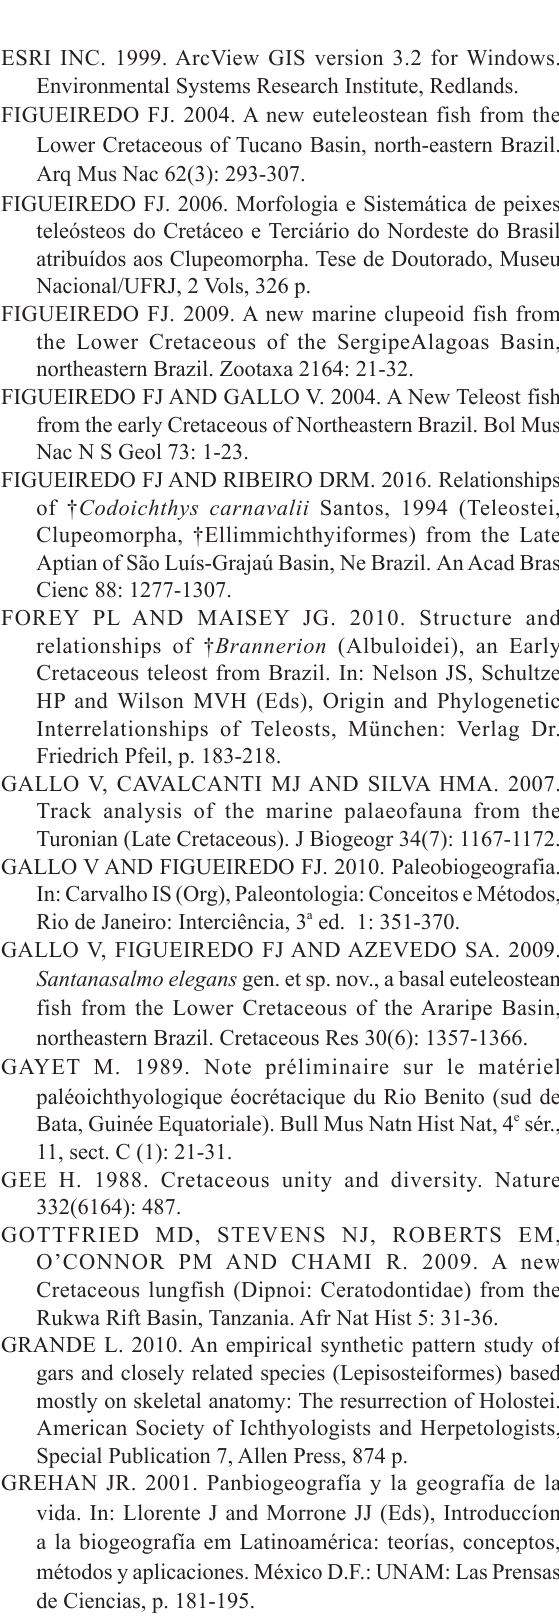
FIGUEIREDO FJ. 2004. A new euteleostean fish from the Lower Cretaceous of Tucano Basin, north-eastern Brazil. Arq Mus Nac 62(3): 293-307. FIGUEIREDO FJ. 2006. Morfologia e Sistemática de peixes teleósteos do Cretáceo e terciário do Nordeste do Brasil atribuídos aos Clupeomorpha. Tese de Doutorado, Museu Nacional/UFRJ, 2 Vols, 326 p. FIGUEIREDO FJ. 2009. A new marine clupeoid fish from the Lower Cretaceous of the SergipeAlagoas Basin, northeastern Brazil. Zootaxa 2164: 21-32. FIGUEIREDO FJ AND GALLO V. 2004. A New Teleost fish from the early Cretaceous of Northeastern Brazil. Bol Mus Nac N S Geol 73: 1-23. FIGUEIREDO FJ AND RIBEIRO DRM. 2016.